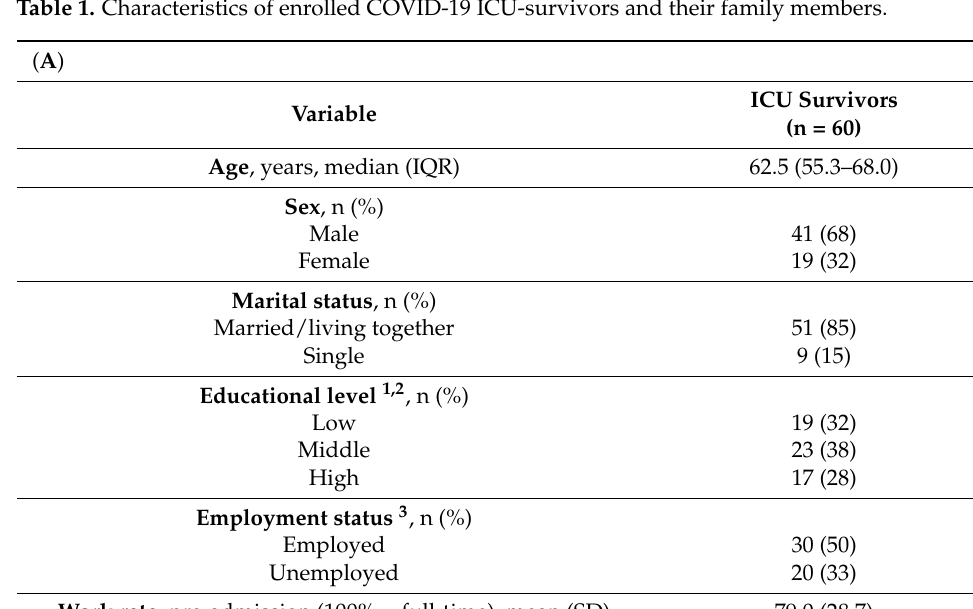
Figure 2. COFICS flow diagram: participant recruitment. Table 1. Characteristics of enrolled COVID-19 ICU-survivors and their family